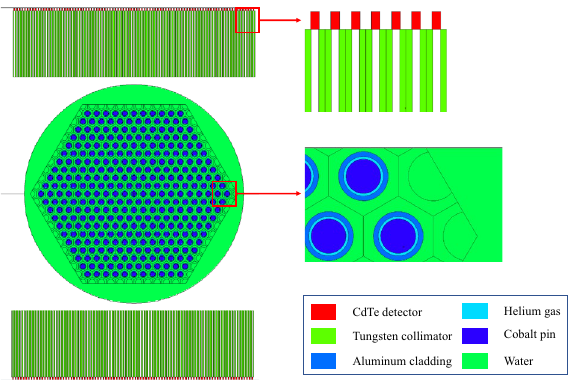
Figure 12. The cross-sectional view of the MCNP model in Case 1. The hexagonal fuel assembly contains 331 60 Co rods and is submerged in a water cylinder of 33 cm diameter. The fuel pin is simulated as a 60 Co cylinder of 7 mm diameter, coated with 1 mm thick aluminum cladding. Gamma rays emitted by the 60 Co rods are detected by two collimated CdTe detector arrays located on two sides of the fuel assembly, each encompassing 91 detectors. The tungsten collimator between the detector array and fuel assembly is 10 cm long and has an aperture of 1.5 mm. Each CdTe detector is closely attached to the collimator and is of size 0.175 0.35 0.35 cm 3 . The distance between two neighbouring detectors is 4 mm. The bottom array is shifted × × to left by 2 mm, with respect to the top one 3,4 . The detector arrays rotate clockwise and scan the fuel bundle in 360 steps of 1 ◦ , which generates a 182 ×